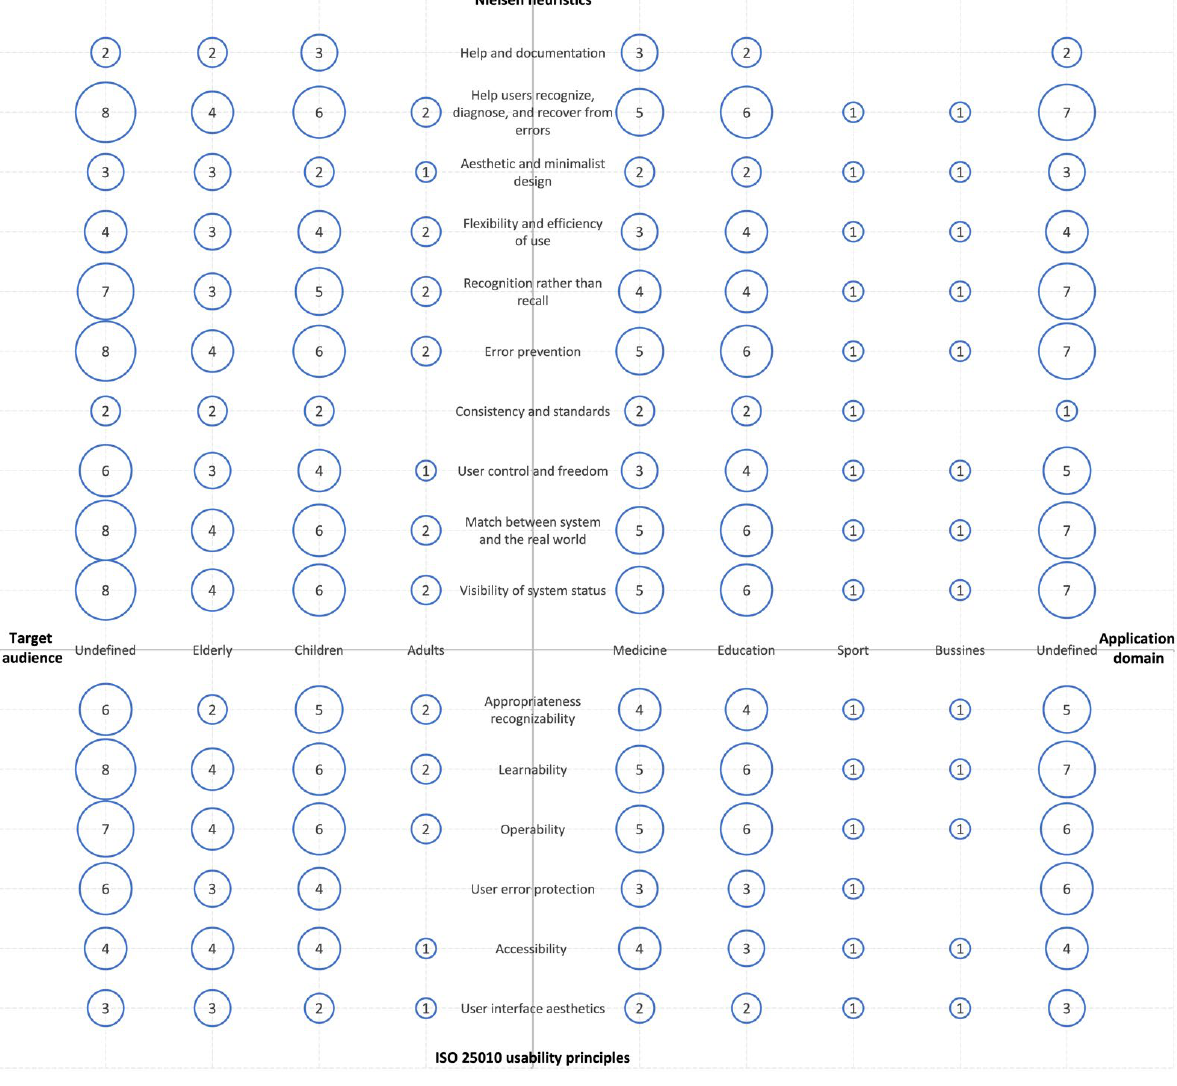
Figure 6. The number of publications with respect to gamified system target audience, application domain and the nature of the recommendations provided in the publication.